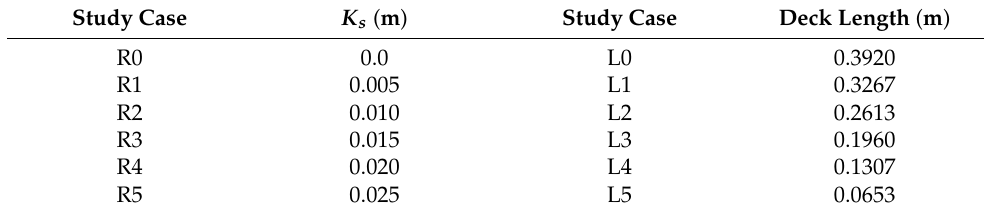
Figure 8. Mean y+ values. ( a ) Roughness cases. ( b ) Deck length cases. Table 3. Study cases simulated with the CFD